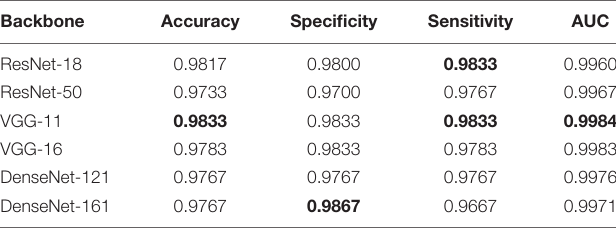
TABLE 2 | Performance of the proposed network with different backbones.